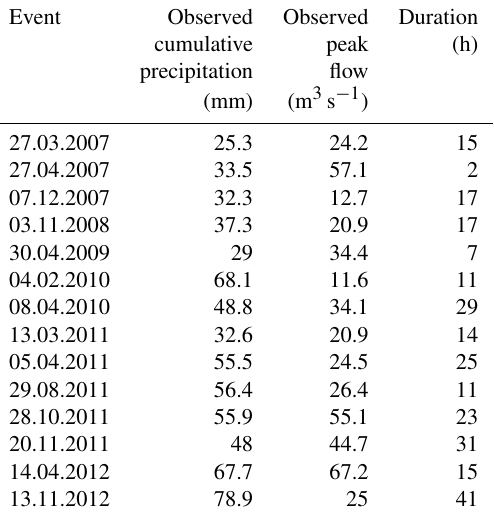
Table 2. Precipitation and streamflow data. Event Observed Observed Duration cumulative peak (h) precipitation flow